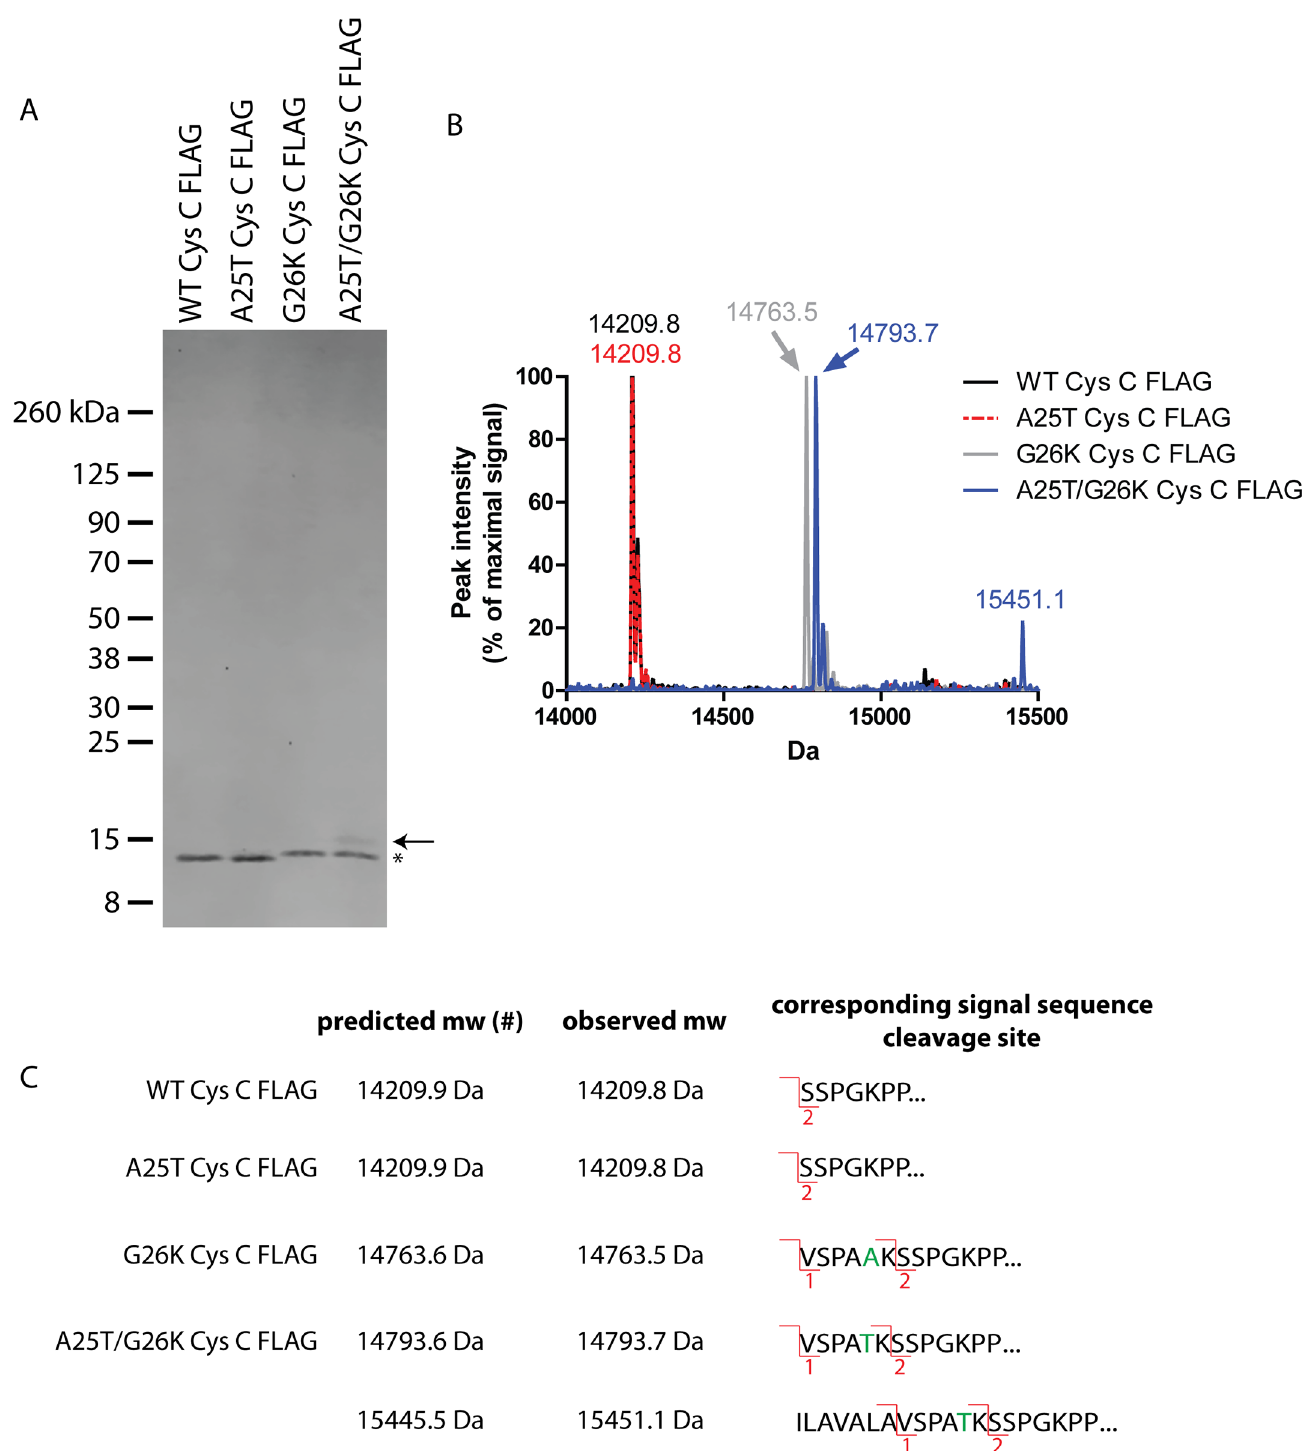
Fig 6. Mass spectrometry (MS) confirmation of Cys C signal sequence cleavage sites. (A) ARPE-19 cells were infected with adenovirus encoding for the designated Cys C FLAG variants and the amount of secreted Cys C was isolated by IP using anti-FLAG M2 beads. Cys C was eluted using the FLAG peptide and run on an SDS-PAGE gel followed by Coomassie Blue staining. Asterisk denotes site 1 cleavage products, whereas the arrow denotes a newly identified cleavage product only found in A25T/G26K Cys C. (B) Intact MS of eluted Cys C purified from ARPE-19 conditioned media. Eluted, IP ’ d Cys C FLAG variants (not separated by SDS-PAGE) were analyzed by intact MS. Numbers above each peak denote molecular weight in Da. (C) Comparison of